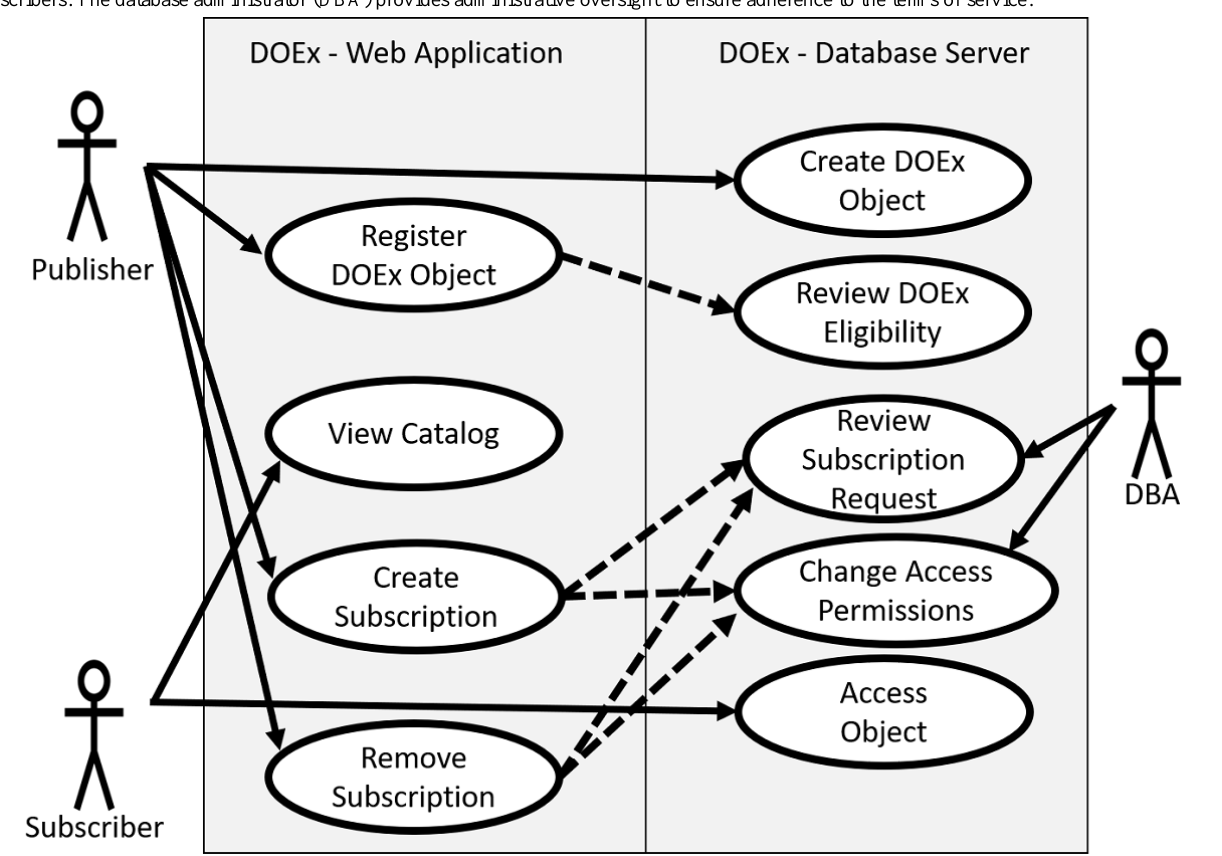
Figure 1. Use case diagram of the Data Object Exchange (DOEx). The DOEx consists of the following two parts: a web application and a database server (gray boxes). Publishers create and register DOEx database objects. Subscribers become aware of shared objects through the DOEx catalog or private communication with the publisher (not shown). Publishers control subscriptions to their DOEx objects through the creation and removal of subscribers. The database administrator (DBA) provides administrative oversight to ensure adherence to the terms of